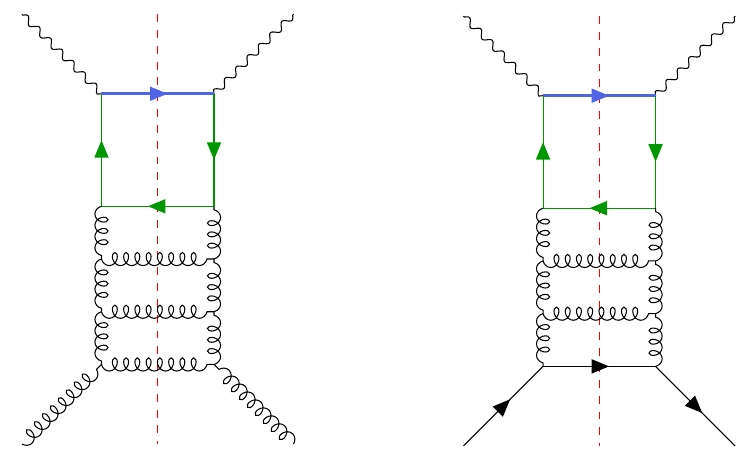
Figure 1 . Representative diagrams that contribute to the DIS structure functions at NLL in the gluon channel (left) and quark channel (right). In the quark loop the (cid:13)avour (and thus the mass) can change in the charged-current case (hence the di(cid:11)erent